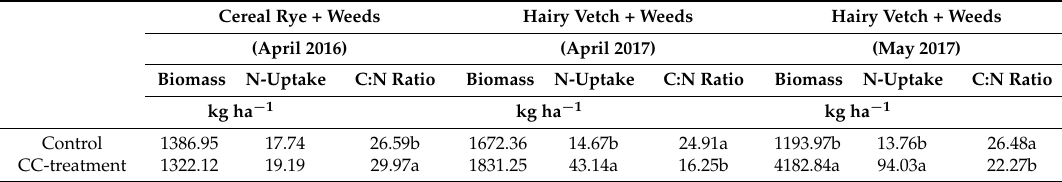
Table 5. Mean biomass production, C:N ratio and N-uptake of weeds in the control watershed and cover crop plus weeds in the CC-treatment watershed in spring of 2016 and 2017. The same letter within a column indicates no significant difference for a given factor or combination of factors ( α =